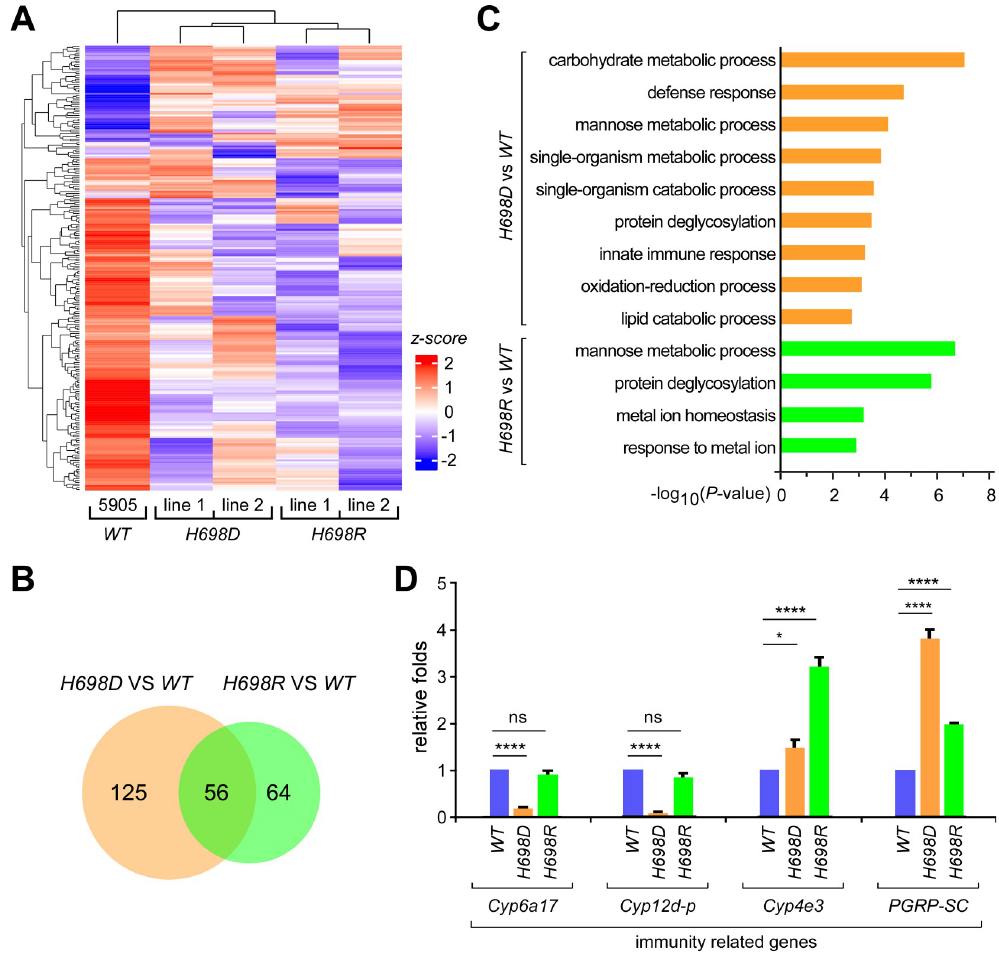
Fig 3. Differentially expressed genes in the two sf3b1 mutants. ( A ) Heat map of the differentially expressed genes. Compared to the WT strain, the expression of 181 genes in H698D and 120 in H698R were significantly changed ( p < 0.05), those are analyzed and presented in the map. ( B ) Overlap of differentially expressed genes in the two mutant strains. ( C ) GO enrichment of differentially expressed genes. Enrichment in H698D and H698R is shown in two distinct groups. ( D ) Validation of differentially expressed genes by qRT-PCR. Statistical data are shown as mean ± SEM, n = 3, two-tailed unpaired Student’s